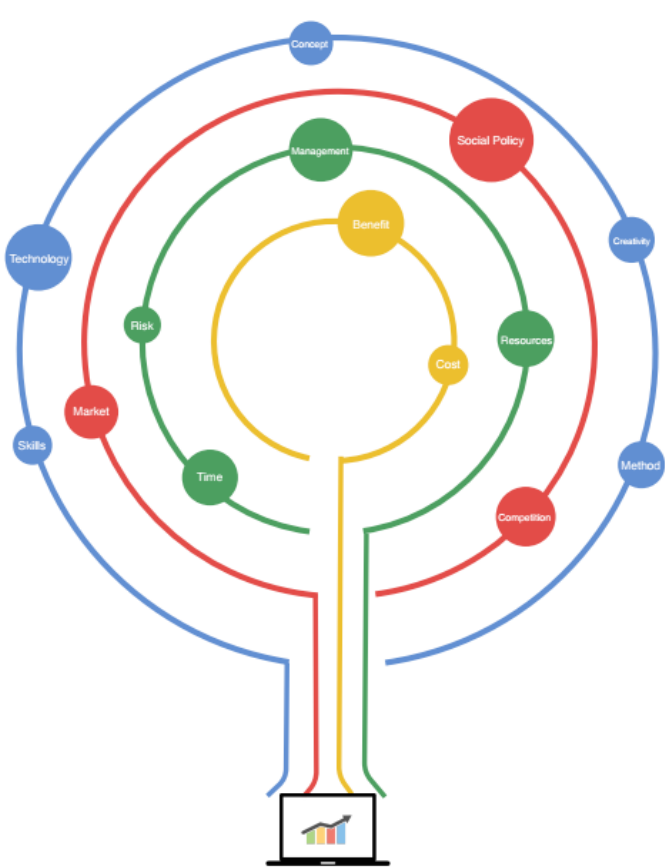
Figure 2. The calculation of an entrepreneur in computational